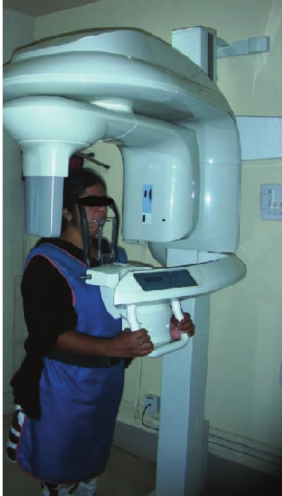
Figure 1: Patient positioned for DVT in Kodak 9000C 3D Extra oral imaging